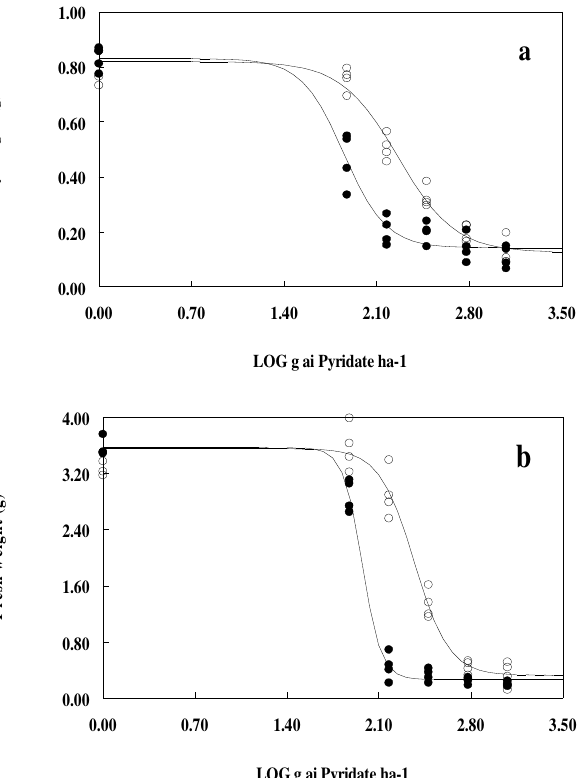
Fig. 1. Dose-response curves for herbicide pyridate alone (  ) and in the presence of methylated rapeseed oil ( (cid:2) ) against common lambsquarters. The lines were fitted on data belong to shoot dry weight (a) and shoot fresh weight